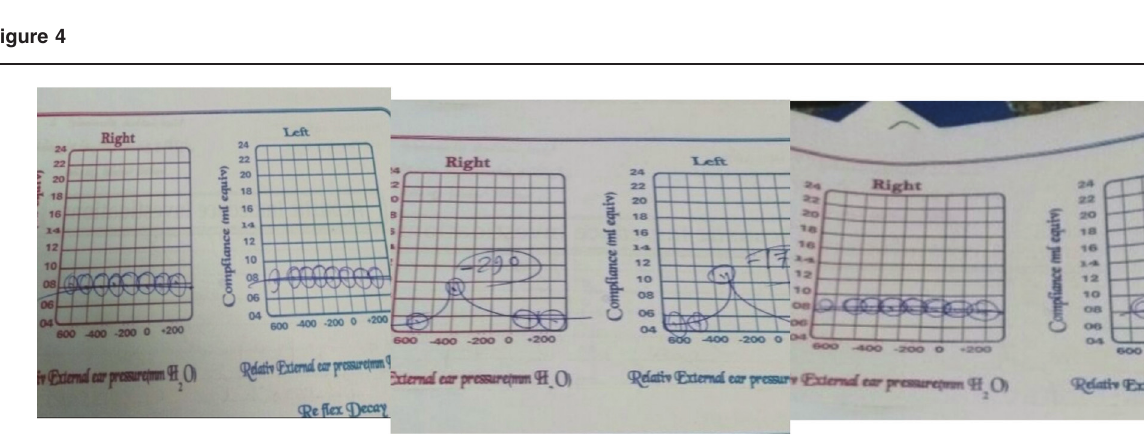
Tympanogram after 2, 4, and 6 weeks of